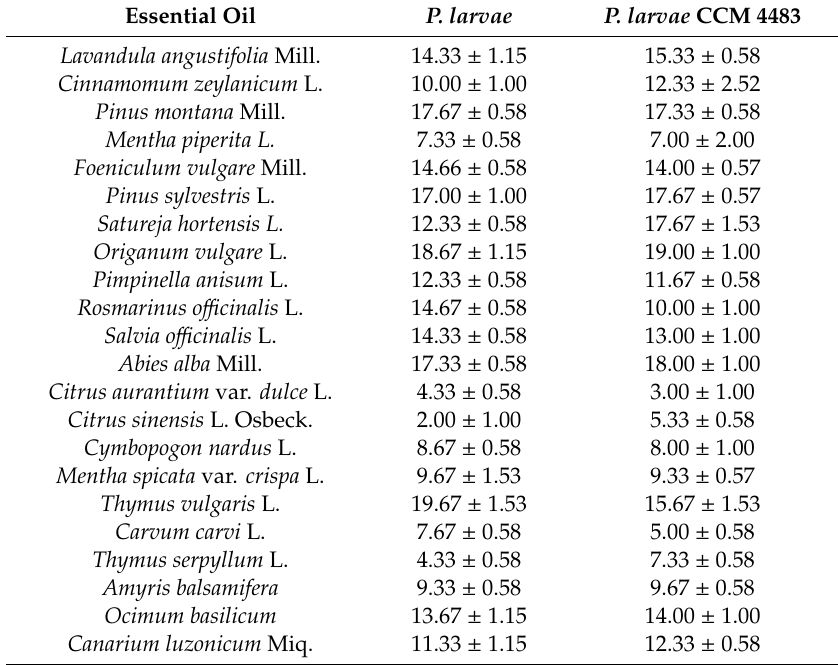
Table 6. Antimicrobial activity of essential oils against P. larvae in